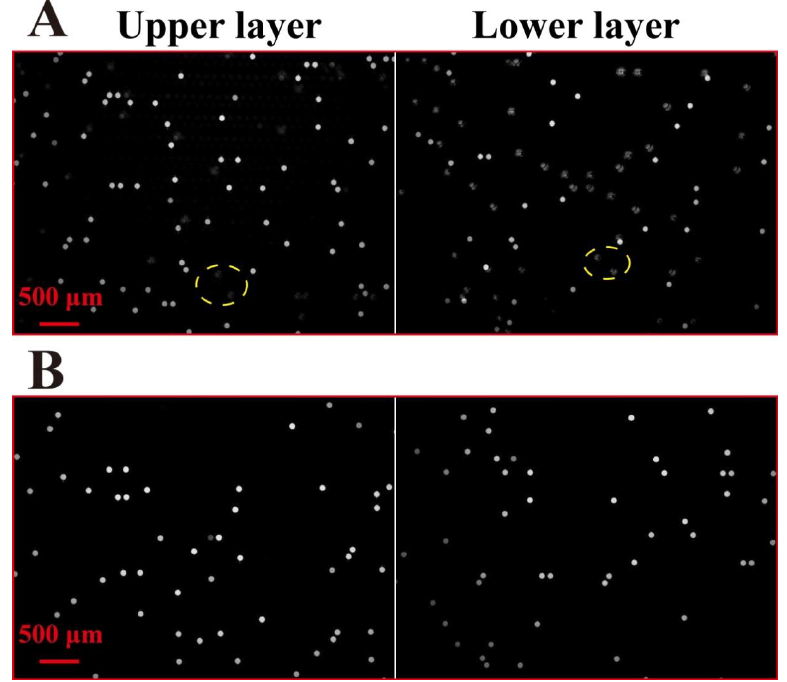
Figure 4. Fluorescence images of KRAS DNA molecule amplification on the transparent PDMS chip ( A ) and black PDMS chip ( B ).